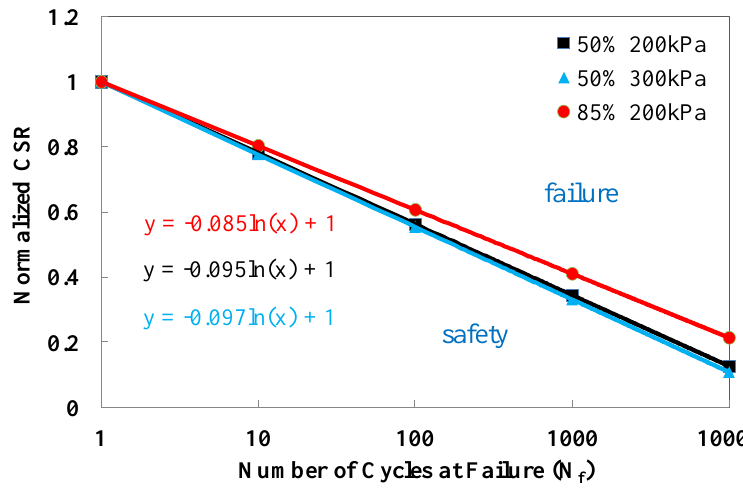
Figure 13. Normalized CSR versus N f .